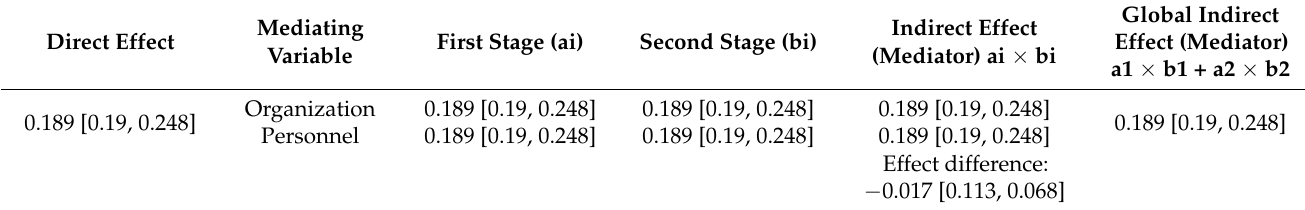
Table 7. The mediating effects of organization and